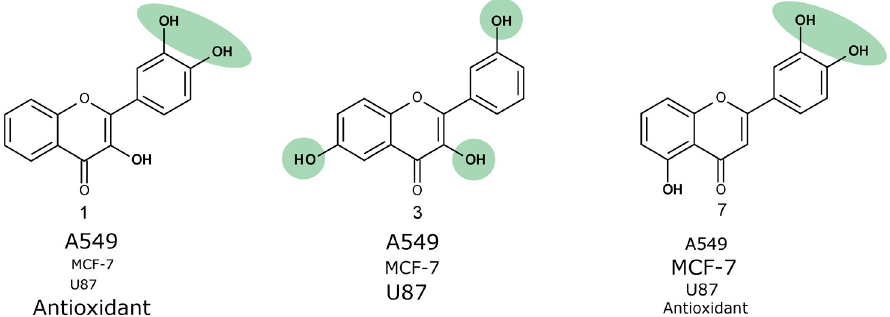
Figure 7. The most active trihydroxyflavones in cancer cell viability and the free-radical scavenging assay in this study. The relative ranking of activity against different cell lines is shown by different font sizes.